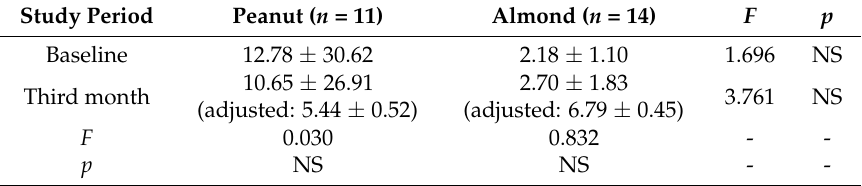
Table 8. Comparison of interleukin-6 (IL-6) (x ± s, pg/mL) in the two groups.